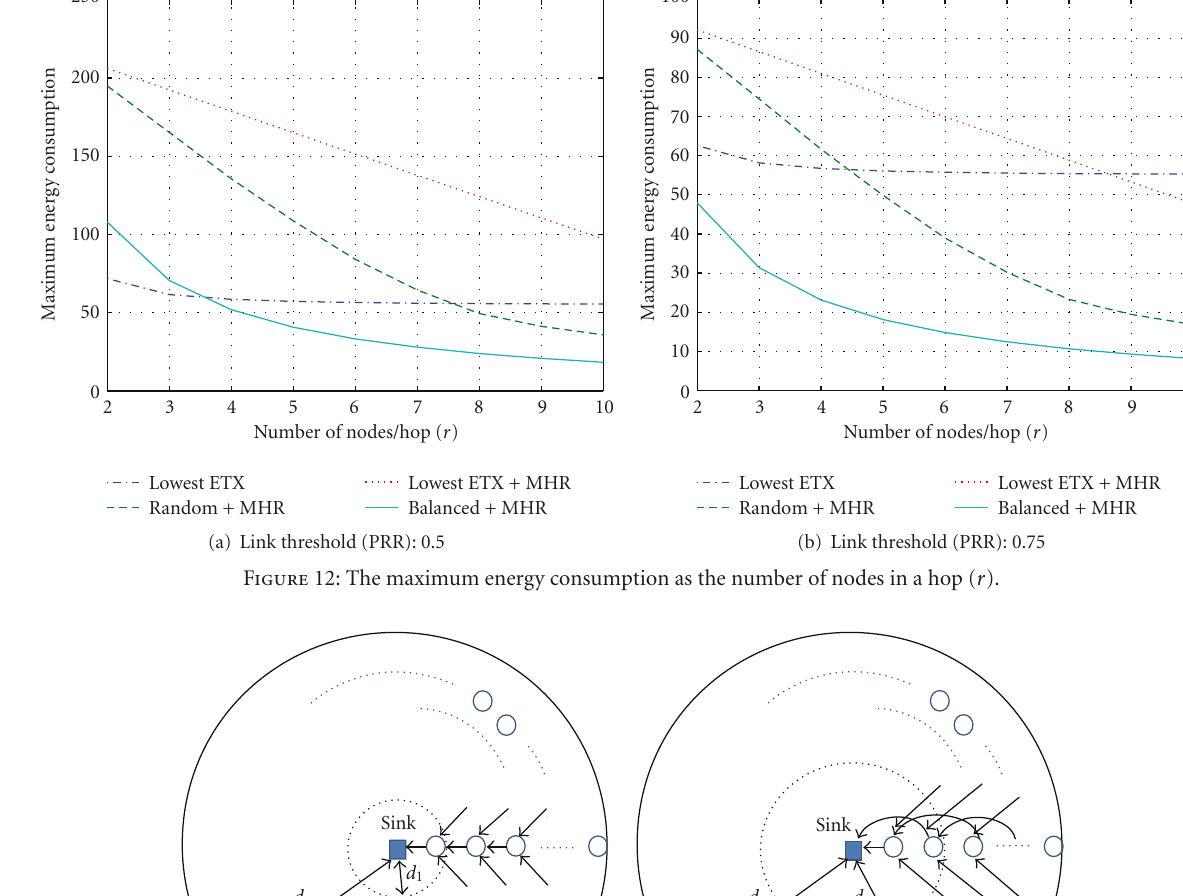
Figure 13: The illustration of a 2D data-gathering tree with the lowest ETX parent selection and the minimum hop routing